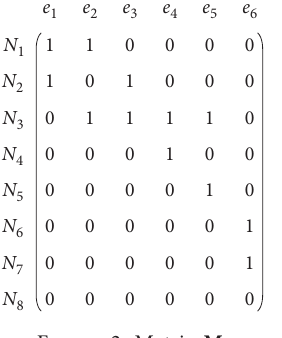
Figure 2: Matrix M